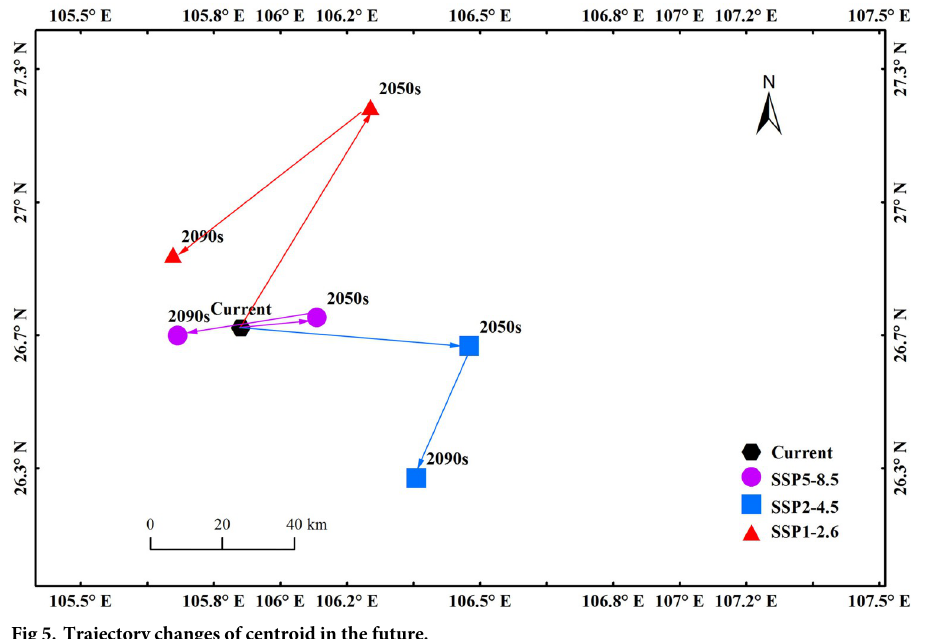
Fig 5. Trajectory changes of centroid in the